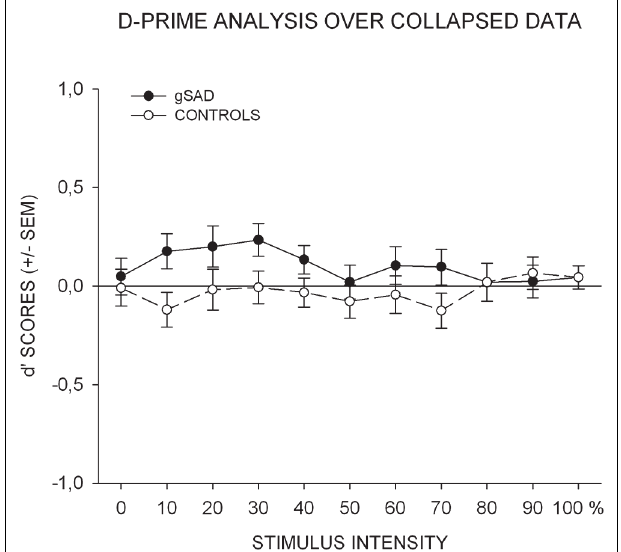
FIGURE 4 |The results of the d (cid:2) score analysis over collapsed data. Average scores are plotted against stimulus intensity ranging from neutral (1) to angry (11). d (cid:2) scores > 1 indicate a bias for “angry” responses in the subliminal angry as opposed to neutral stimulus condition. gSAD, generalized social anxiety disorder; SEM, standard error of